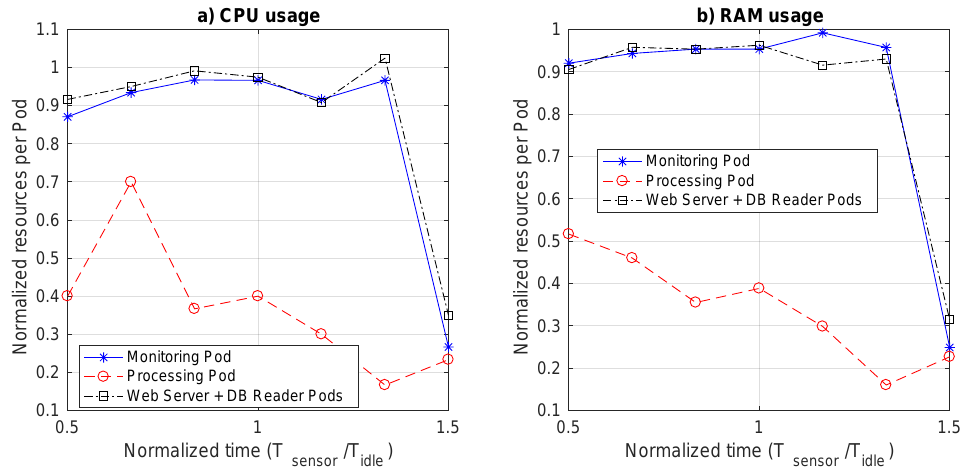
Figure 14. Normalized resource consumption in terms of CPU ( a ) and RAM ( b ) of the cold start option with respect to that of the warm start one, as a function of the normalized data arrival